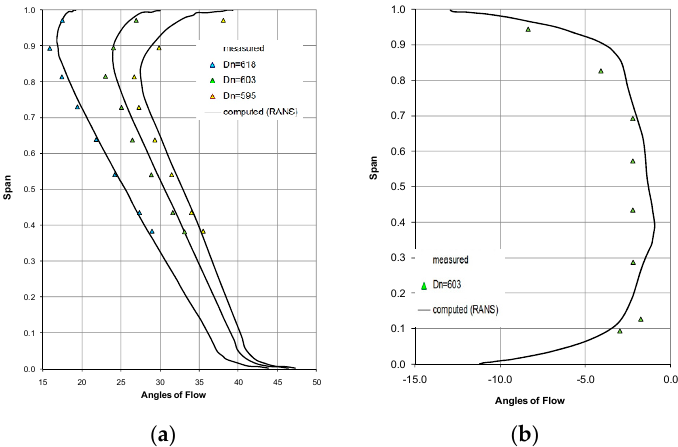
Figure 14. Comparison of computed (3D-RANS) and measured flow angles, α , at the Rotor 1 ( a ) and Rotor 2 ( b ) outlets, (cid:1866) (cid:3364) cor = 70%.